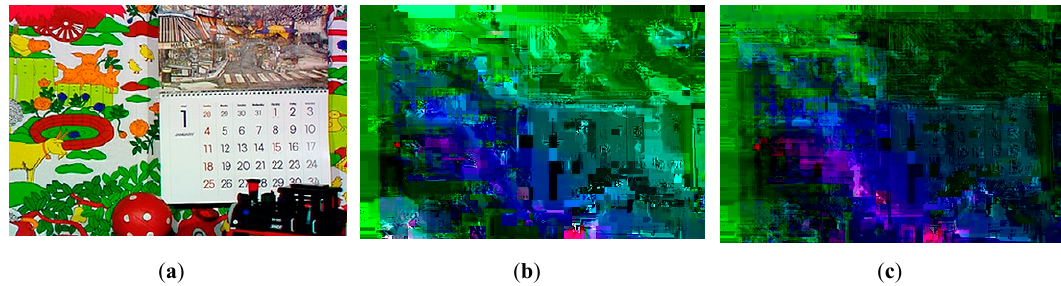
Figure 14. Key sensitivity analysis. ( a ) Original frame; ( b ) decrypted with K1; ( c ) decrypted with K2.